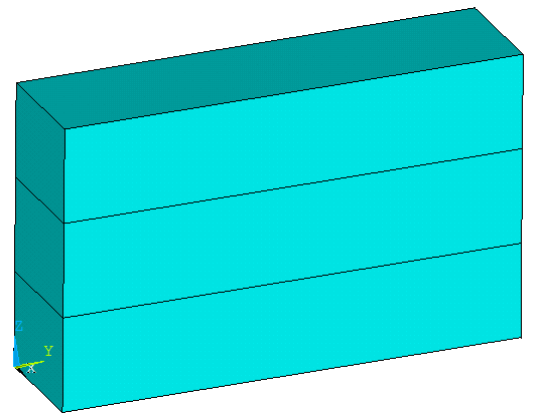
Figure 9. Multibody contact.